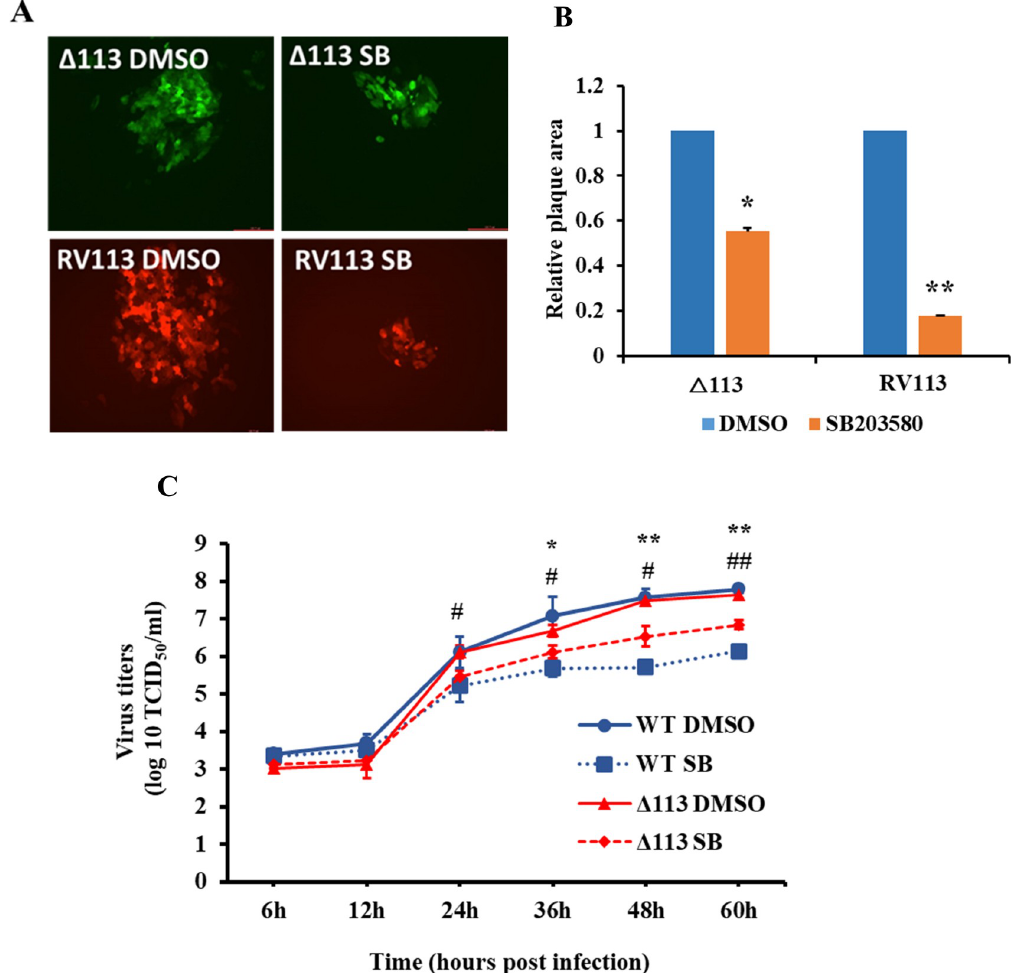
Fig 5. p38 signaling affects ORFV replication and plaque formation. (A and B) Effect of p38 inhibitor (SB203580) on ORFV plaque size. OFTU cell were pretreated with vehicle control (DMSO) or SB203580 for 1 h and infected with OV-IA82 Δ 113 ( Δ 113;GFP reporter) or OV-IA82RV113 (RV113;RFP reporter) and plaque assays were performed in presence of DMSO or SB203580. Shown are representative fluorescent plaque images taken at 5 days p.i. (B) Random plaques were imaged (n = ~100), and plaque areas measured using Nikon A1 software. p38 inhibitor treated Δ 113 and RV113 plaques compared to DMSO treated Δ 113 and RV113 plaques are shown. Results are average of two independent experiments. Error bars represent mean ± SD. Statistical analysis was performed using paired Student’s t-test ( � , P < 0 . 05 ; �� , P < 0 . 01 ). (C) Effect of p38 inhibitor (SB203580) on ORFV replication, OFTU cell pretreated with vehicle control (DMSO) or SB203580 for 1 h were infected with OV-IA82 or OV-IA82 Δ 113 (MOI:0.1) in presence of DMSO or SB203580. Cultures were harvested at various time points and viral titers determined and expressed as TCID 50 /ml. Results are average of three independent experiments. Error bars represent mean ± SD. Statistical analysis was performed using paired Student’s t-test ( � , # , P < 0 . 05 ; �� , # # , P < 0 . 01 ). � and # denote statistical significance of DMSO OV-IA82 Vs SB203580 OV-IA82 and DMSO OV-IA82 Δ 113 Vs SB203580 OV-IA82 Δ 113,